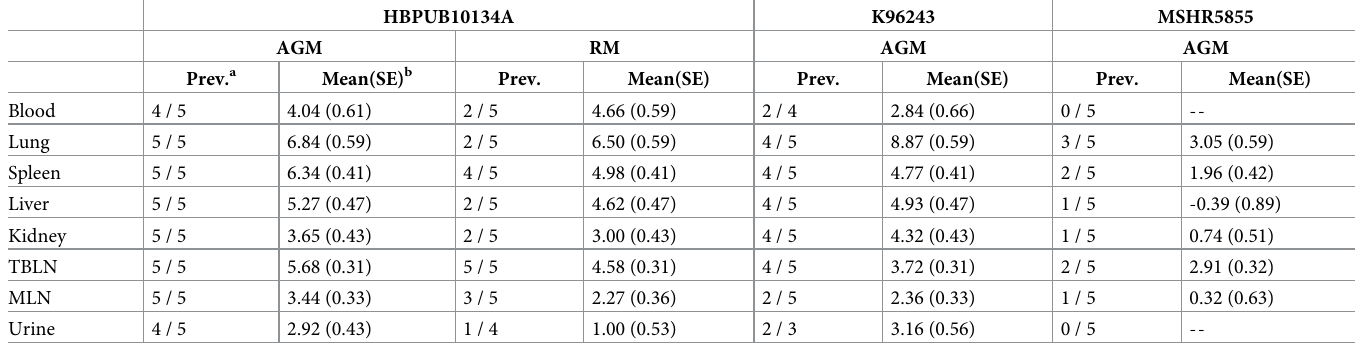
Table 3. Bacteremia and bacterial burdens post-exposure to B . pseudomallei .